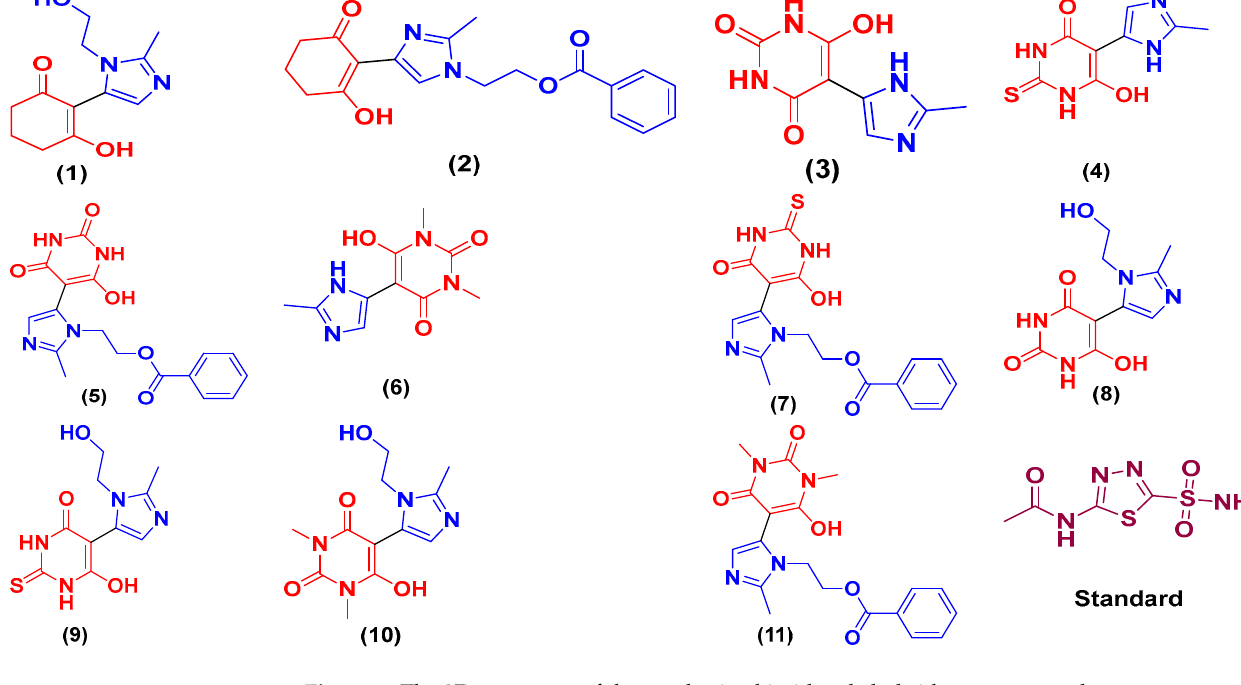
Figure 2. The 2D structures of the synthesized imidazole hybrids are presented. 3-hydroxy-2-(1-(2-hydroxyethyl)-2-methyl-1H-imidazol-5-yl) cyclohex-2-en-1-one ( 1 ) Yield: 35% (70 mg) as light brown solid; purification: chromatography: DCM: MeOH (9.5:0.5 to 3:1) over silica; m.p = 186–190 °C; FTIR (cm − 1 ): V (C=O) = 1684, V (C=C) = 1600, V (C=N) = 1515, V (C-O) = 1276; 1 H NMR (600 MHz, DMSO- d 6 ): δ 14.89 (s, O 12 1H), 7.56 (s, C 8 1H), 4.95 (t,